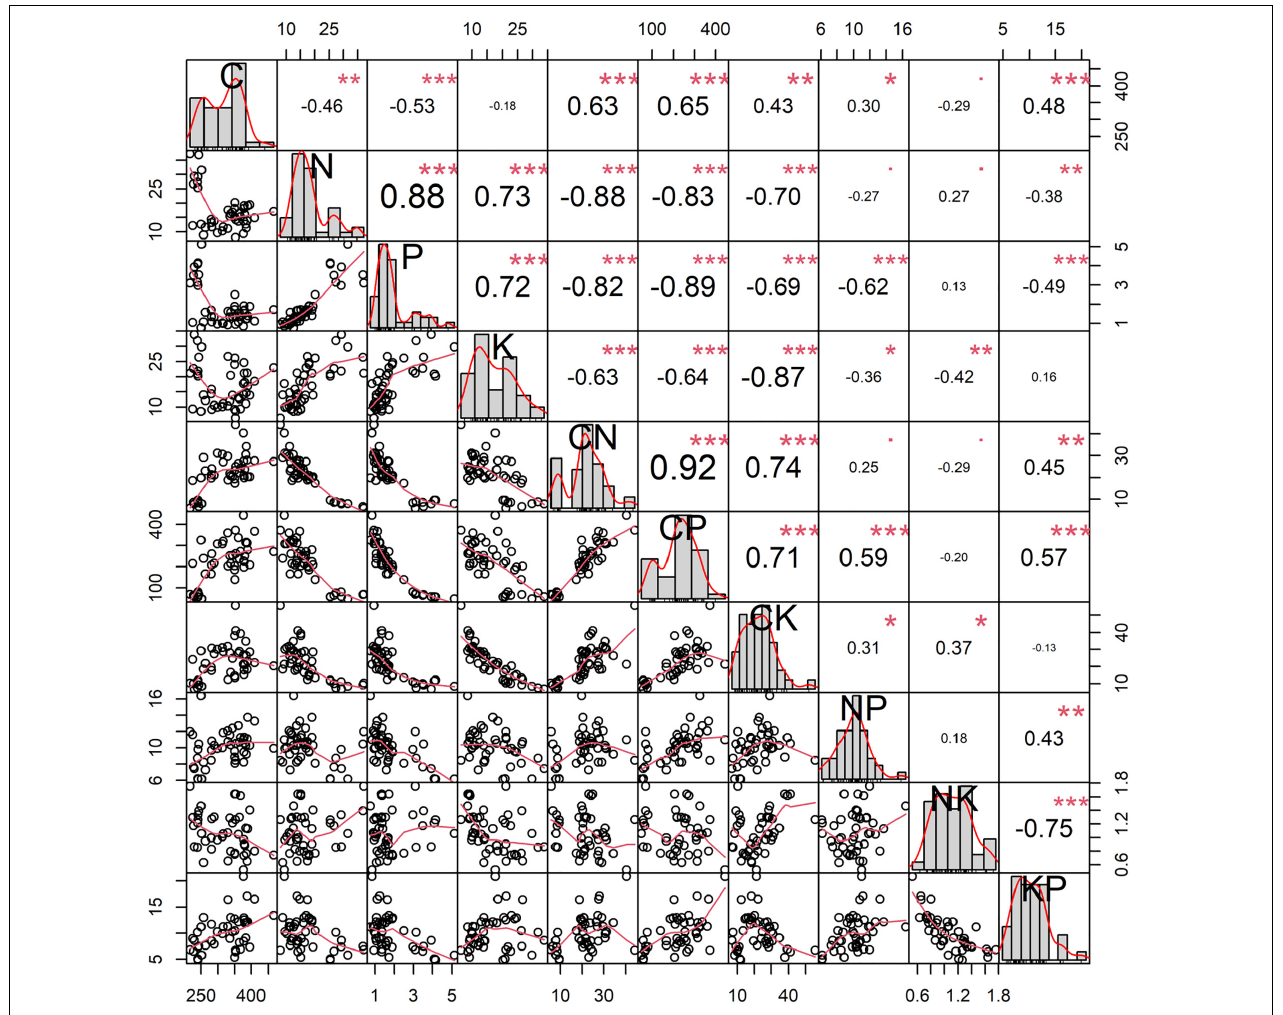
FIGURE 6 | The correlations between C, N, P, and K concentrations and the corresponding ratios of Carex schmidtii . * p < 0.05; ** p < 0.01; *** p < 0.001.